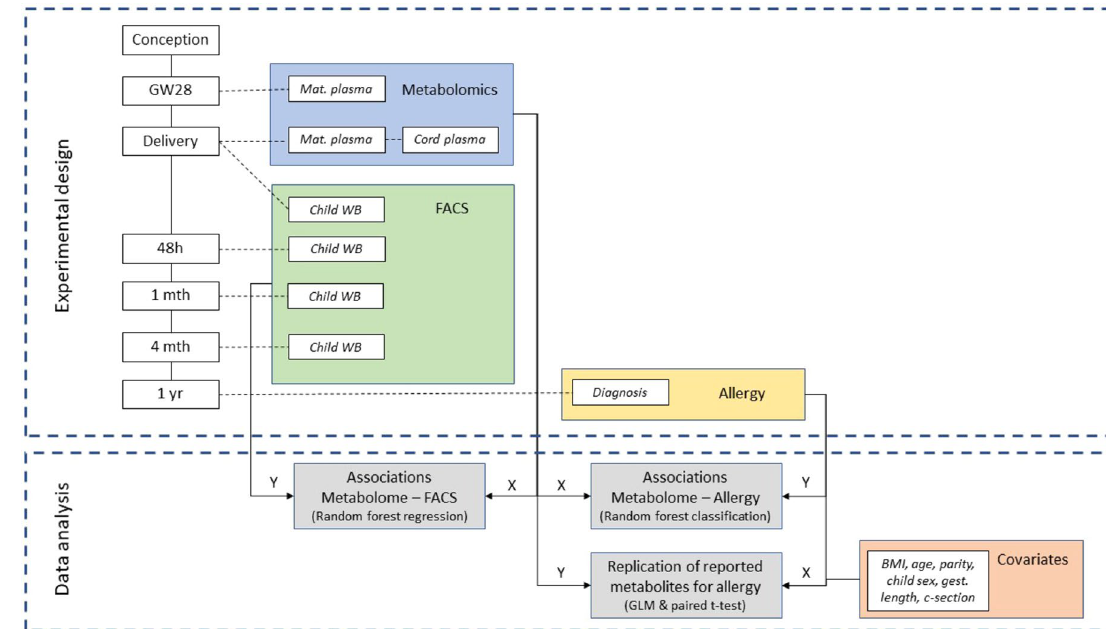
Figure 2. Timeline of sampling and analytical flow chart of data